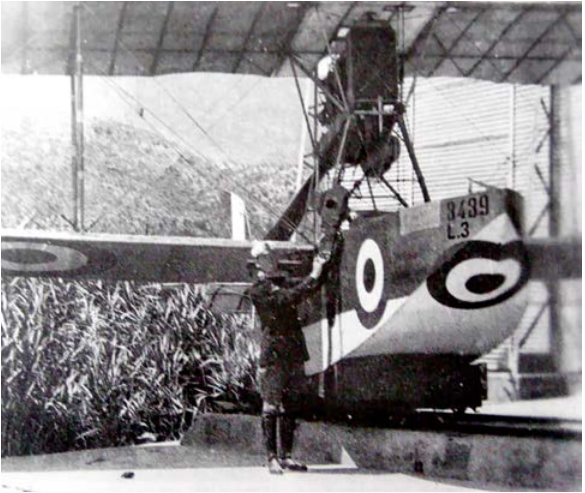
Figure 4. Seaplane Macchi L3,